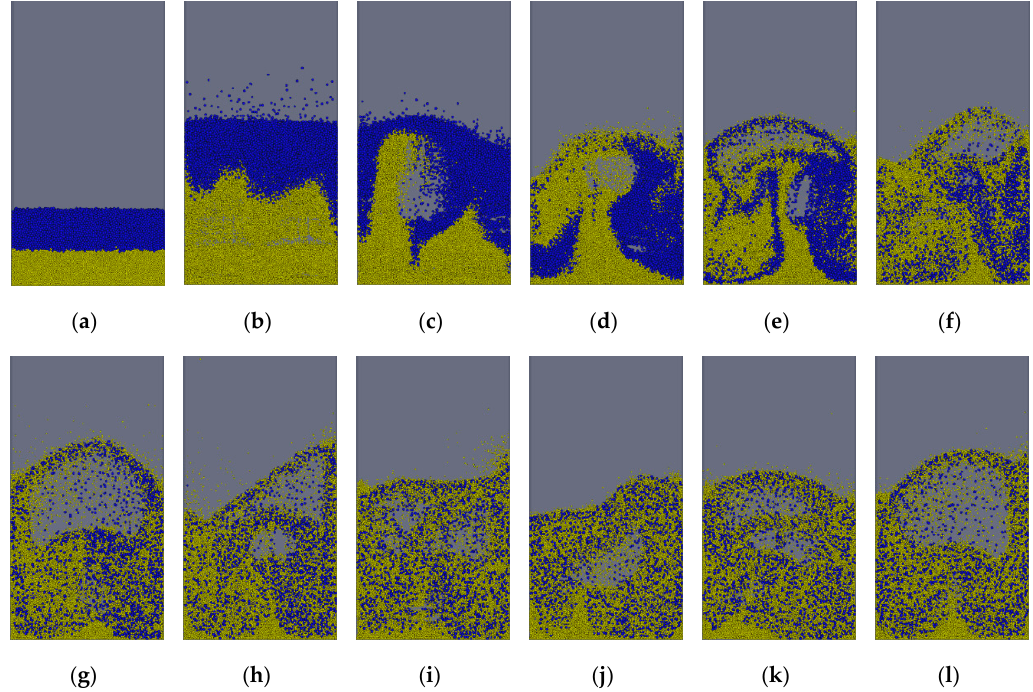
Figure 5. Evolutions of the flow pattern and mixing process in the binary BFB: ( a ) 0 s; ( b ) 0.5 s; ( c ) 1.0 s; ( d ) 1.5 s; ( e ) 2.0 s; ( f ) 3.0 s; ( g ) 4.0 s; ( h ) 5.0 s; ( i ) 6.0 s; ( j ) 7.0 s; ( k ) 8.0 s; ( l ) 9.0 s.